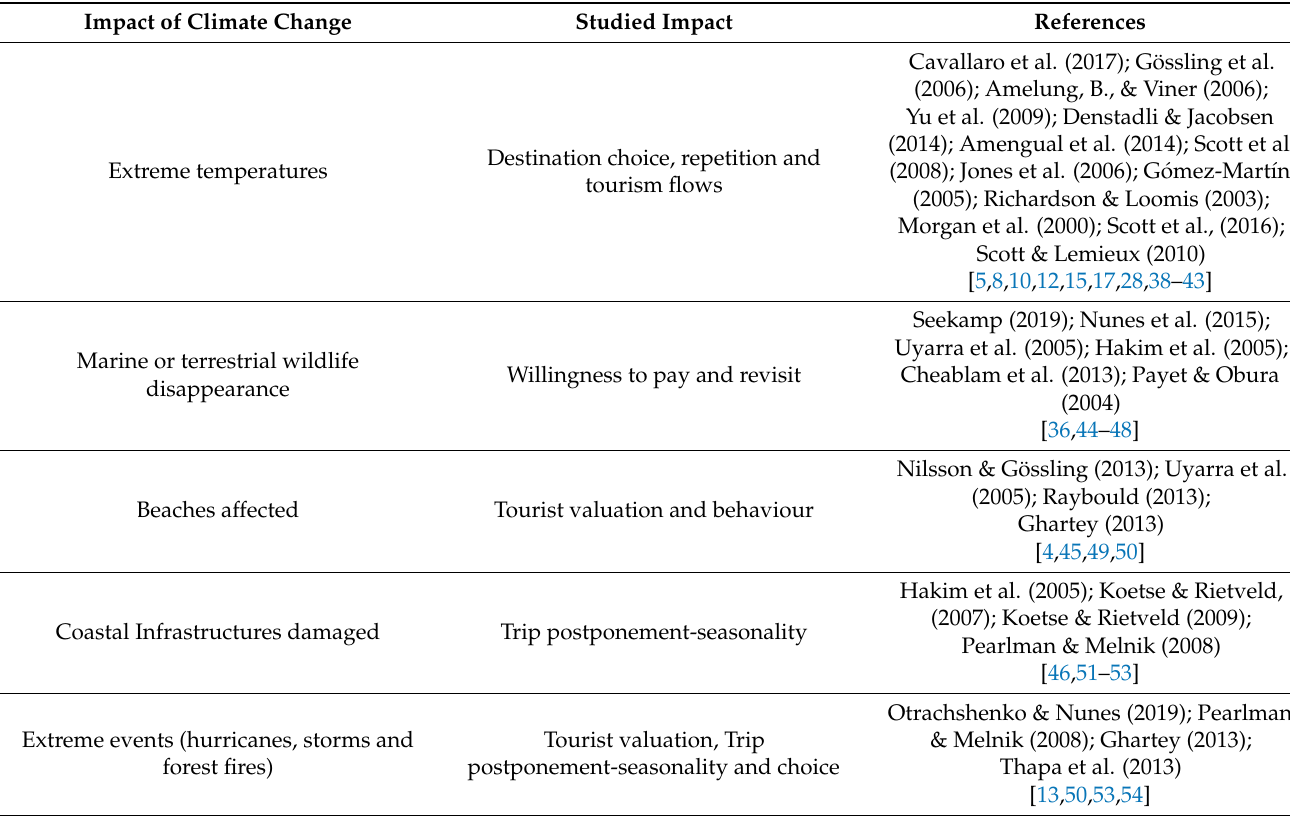
Table 1. Publications on the effects of climate change on tourists’ destination choice